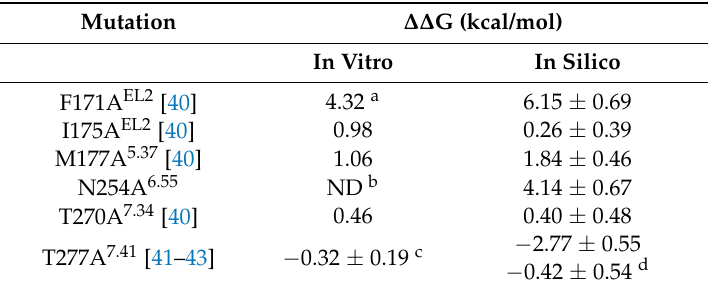
Table 1. Mutational effects on DPCPX affinity for A 1 AR. The experimental affinities were retrieved from the GPCRdb and the reference(s) are given in brackets. The binding affinity (pK D ) was